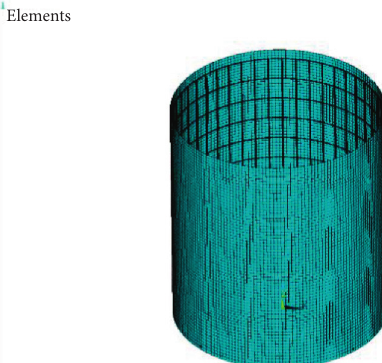
Figure 17: Steel cylinder numerical simulation model